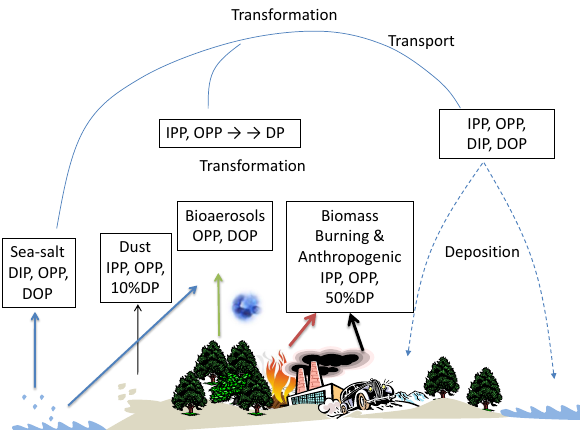
Figure 1. Simplified illustration of the atmospheric P cycle show- ing the various sources of particulate inorganic and organic P (IPP, OPP) and their soluble forms (DIP and DOP), the transformation of PP to DP during atmospheric transport and the deposition of P to the land and to the ocean. Emissions fractions among atmospheric P forms are those used as input in the TM4-ECPL